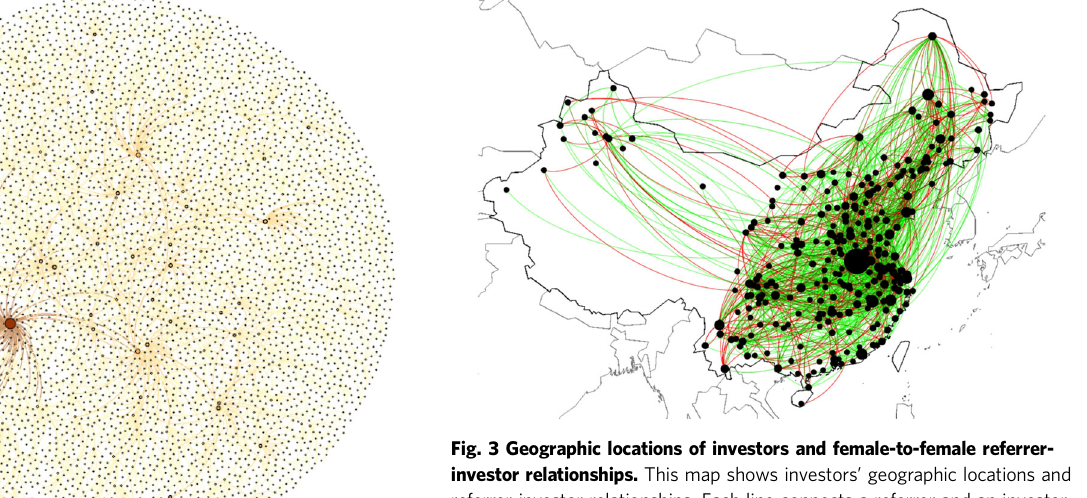
while the coef fi cients on Young-to-Old and Old-to-Young are both insigni fi cant, the coef fi cient on Old-to-Old is positive and signi fi cant ( − 0.0573, t = − 2.71). Therefore, the female-to-female return by 5.05 or 5.73% (Fig. 6). In Column (3) where both gender and age-based investor af fi nities are included, the